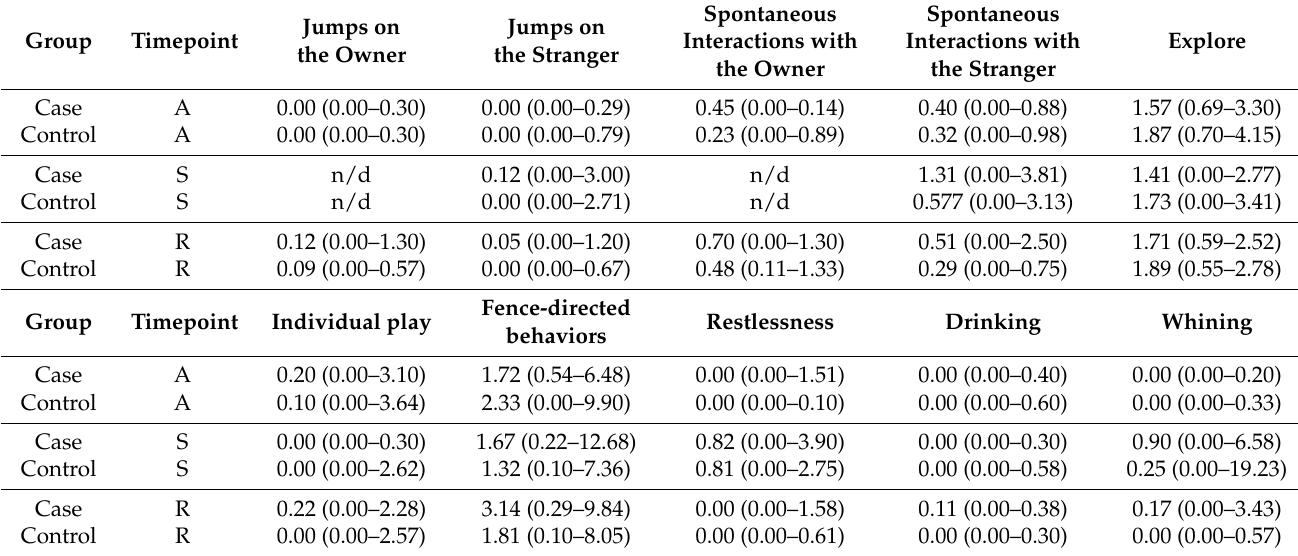
Table 3. Median (minimum–maximum) relative frequency of behaviors expressed by dogs across the three